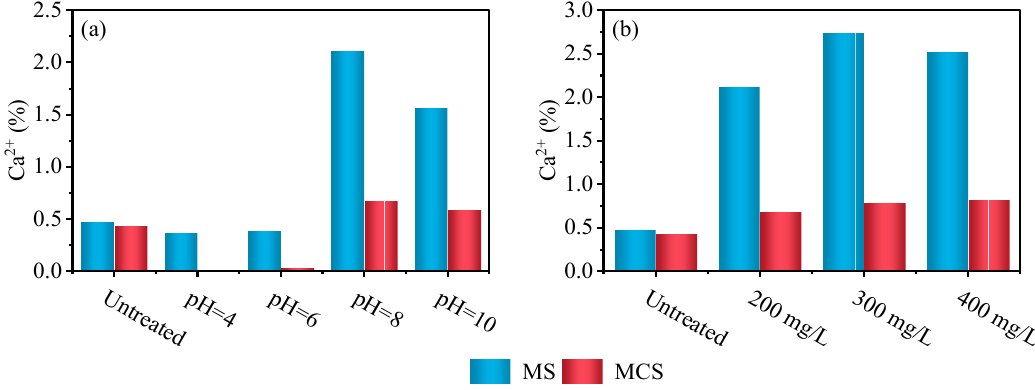
Figure 14. Calcium ion concentration on the surface of the rock sample: ( a ) Solutions with different PH values; ( b ) Solutions with different Ca 2+ concentrations.